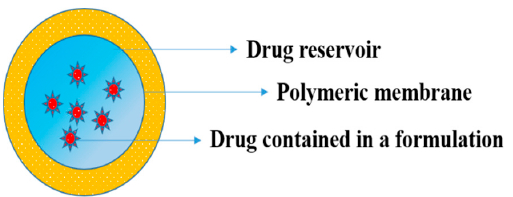
Figure 11. Polymeric membrane used for drug delivery system.